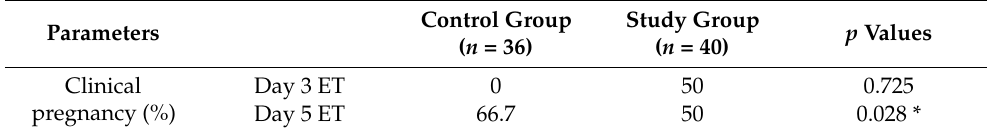
Table 3. Comparison of clinical pregnancy rate according to the day of embro transfer.